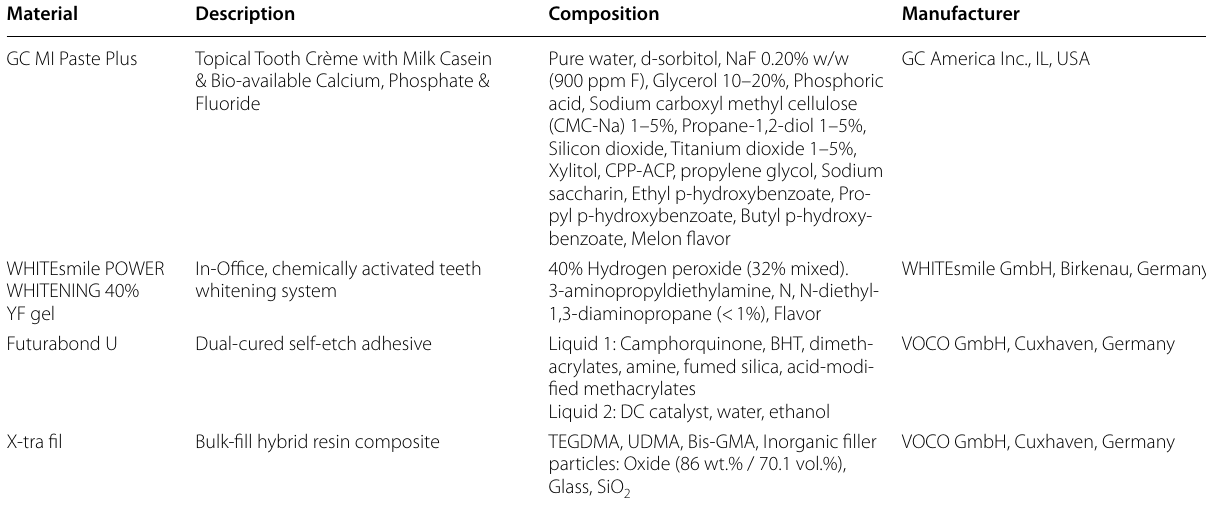
Table 1 Investigated materials, description, ingredients, and